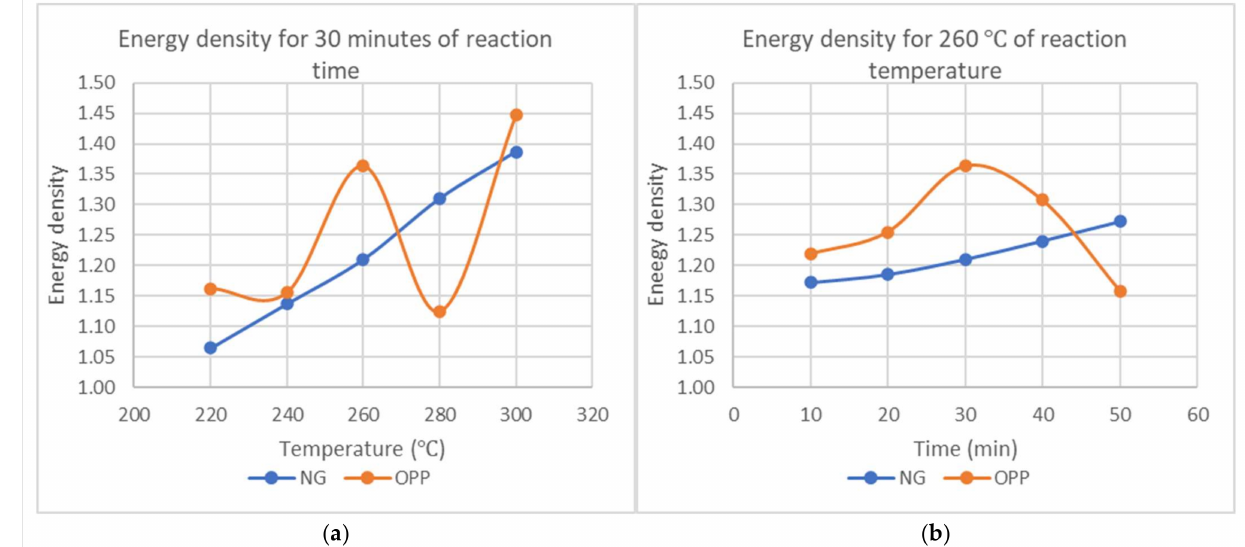
Figure 8. Energy density ( a ) against temperature at constant reaction time of 30 min and ( b ) against reaction time at constant temperature of 260 ◦